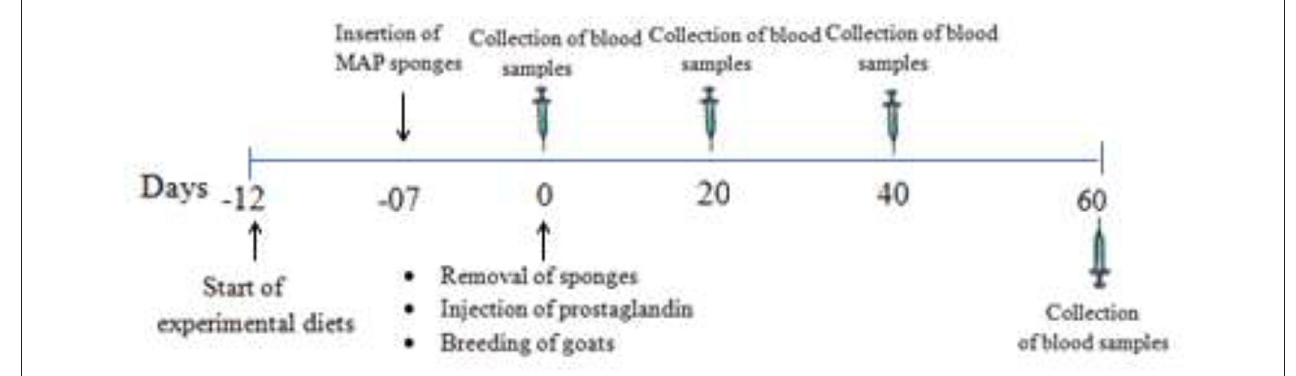
FIGURE 2 | Schematic diagram of experiment protocols.